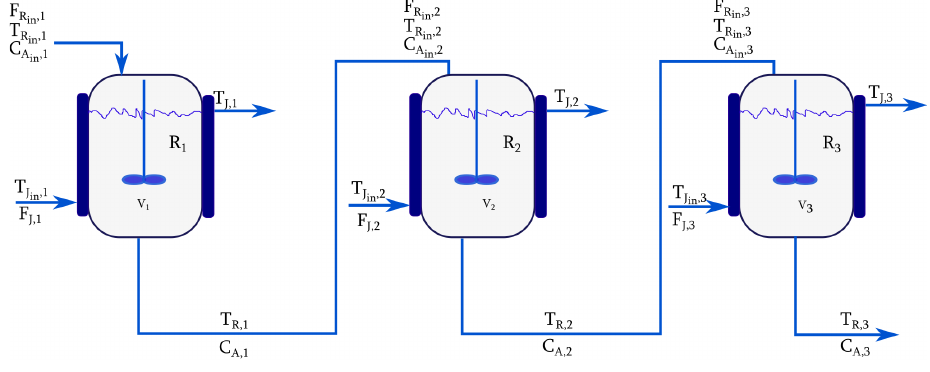
Figure 1. System of three CSTR reactors in series.